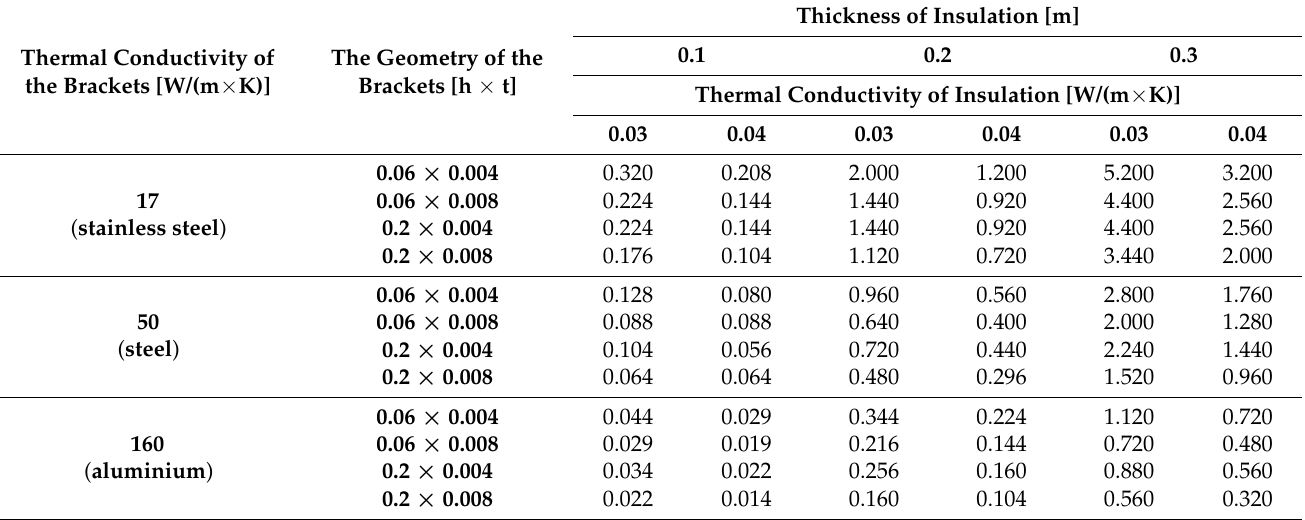
Table 4. “ α ” multiplication correction factors for 30 cm thick masonry wall ( λ = 0.19 W/(m ×